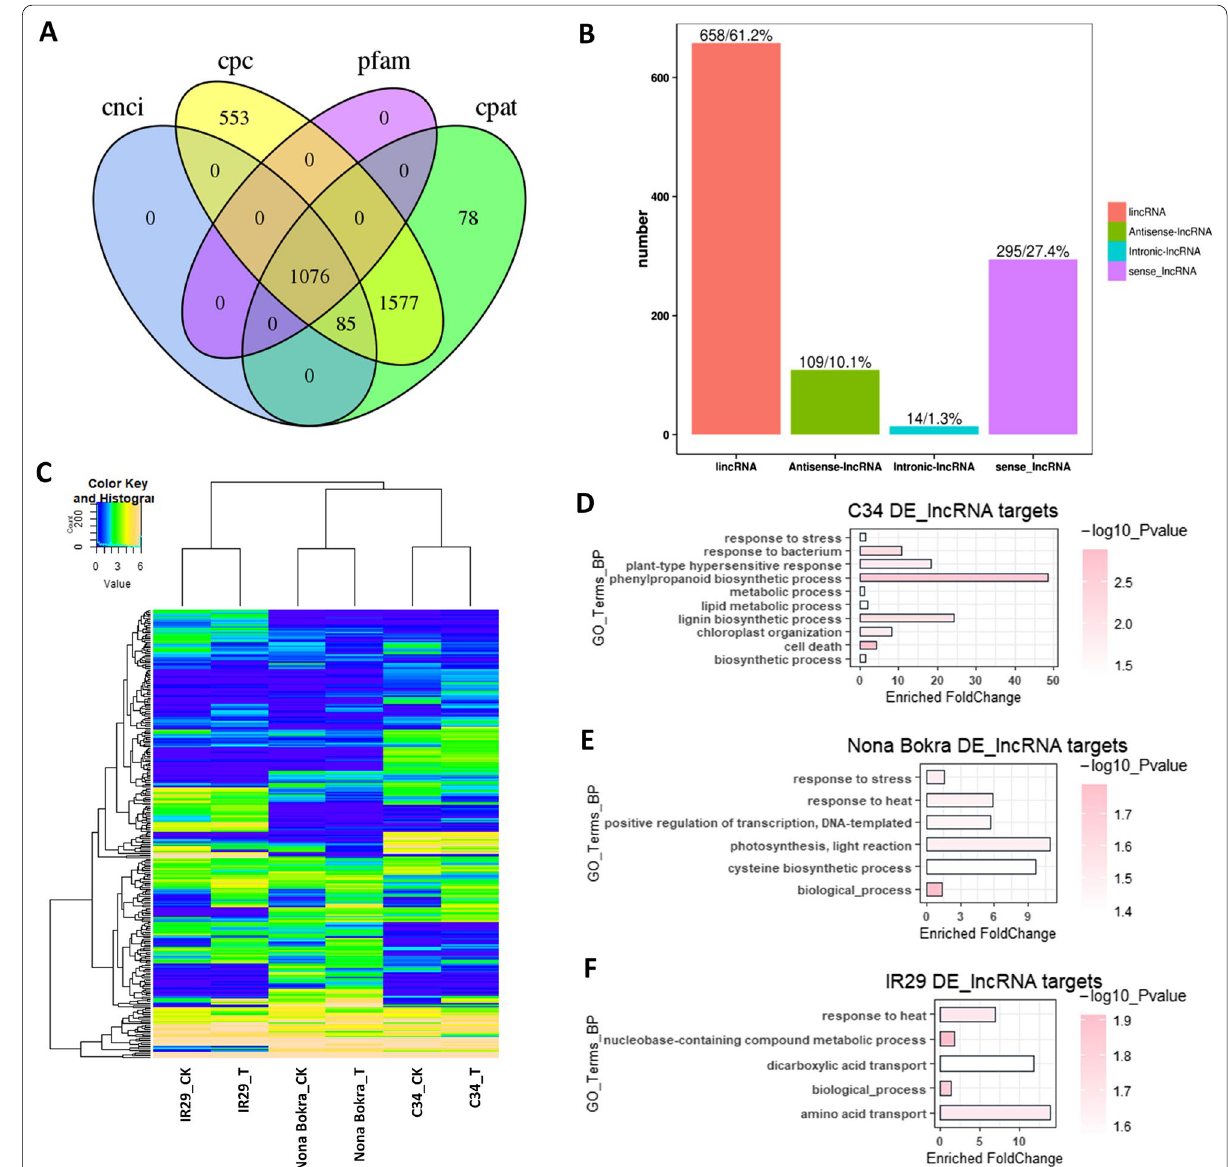
Fig. 6 Characteristics of differential expressed (DE) lncRNAs and their targets. A . Numbers of long noncoding RNA (lncRNA) predicted from four different platforms (databases). B . Ratios of different types of lncRNA. C . A heatmap showing expressional levels of predicted lncRNAs. D to F , Biological processes enrichment of target genes of differential expressed lncRNAs in each rice variety. D . ‘C34’. E . ‘NB’. F .